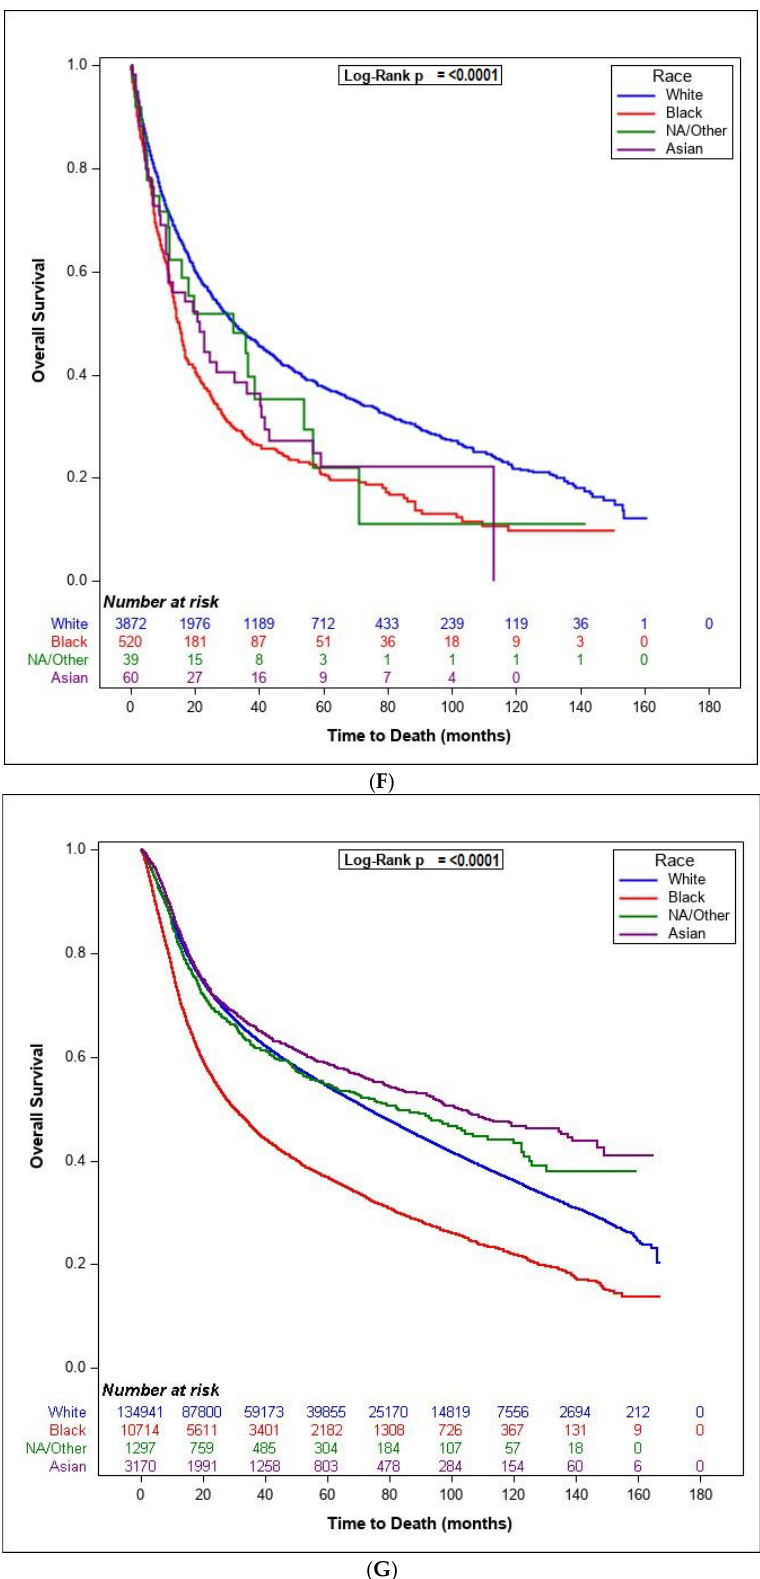
Figure 3. Overall Survival by Racial/Ethnic Minority for the ( A ) Hypopharynx; ( B ) Larynx; ( C ) Nasal Cavity; ( D ) Nasopharynx; ( E ) Oropharynx; ( F ) Pharynx (NOS); ( G ) Oral Cavity.